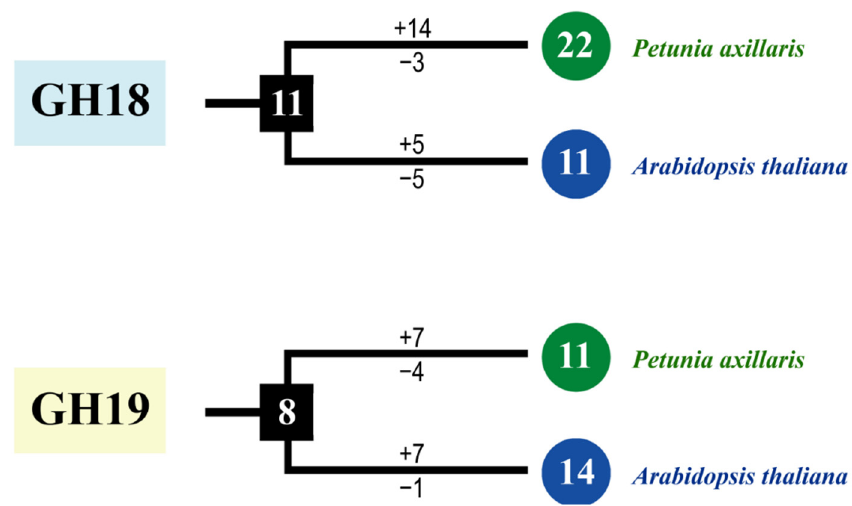
Figure 4. The copy number changes of P. axillaris and A. thaliana CTLs. Numbers in ellipses and rectangles represent the numbers of CTLs in extant and ancestral species, respectively. Numbers on branches with plus and minus symbols represent the numbers of gene gains and losses, respectively.